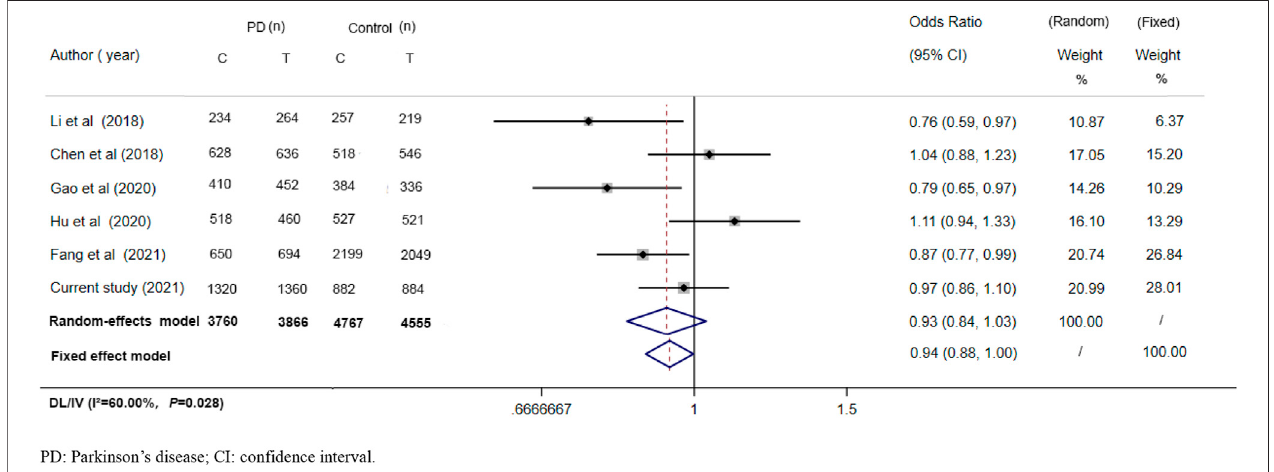
FIGURE 1 | Forest plot for IL1R2 rs34043159 on PD risk in Chinese. PD: Parkinson ’ s disease; CI: con fi dence interval.